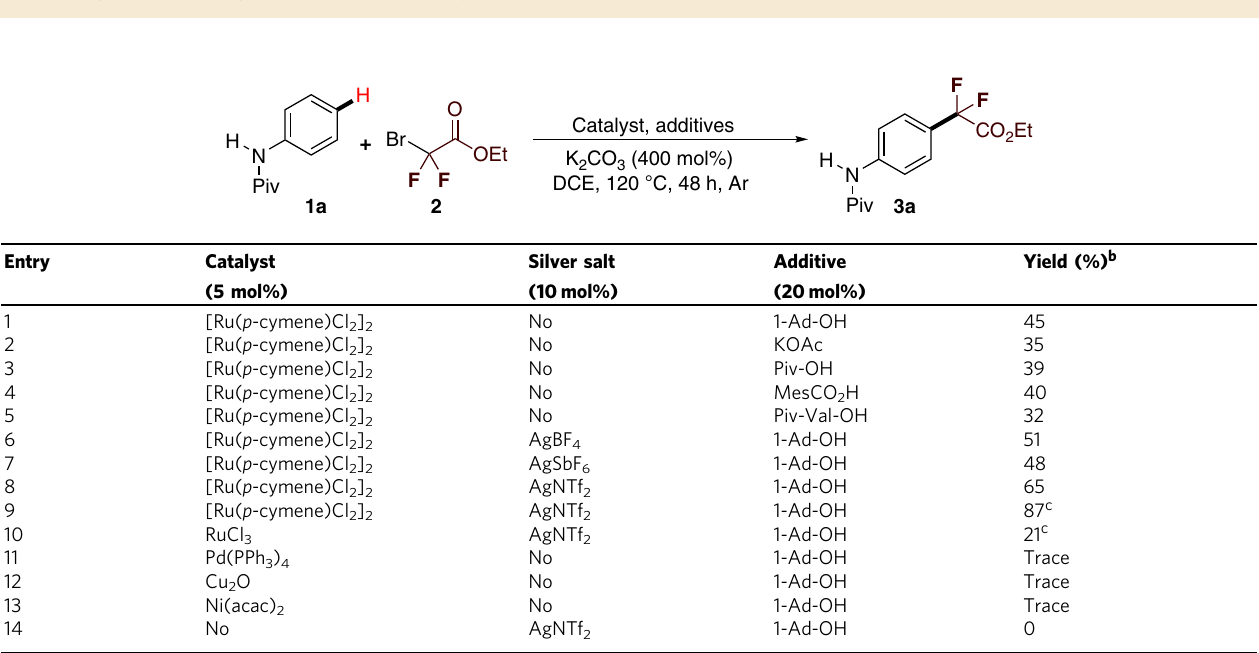
Table 1 Optimization of para -C – H di fl uoromethylation